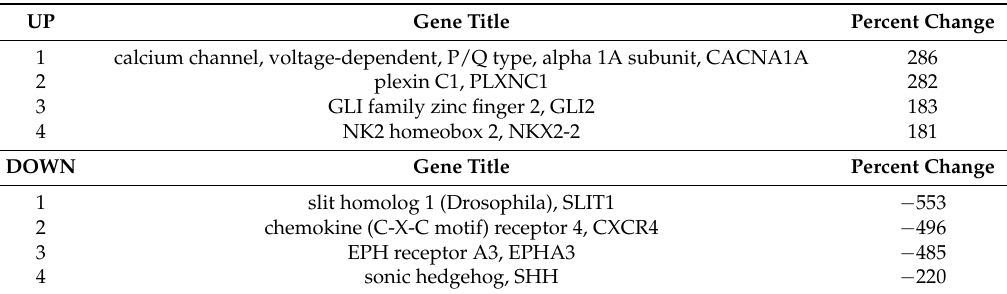
Table 14. GHK and Genes Associate with Motor